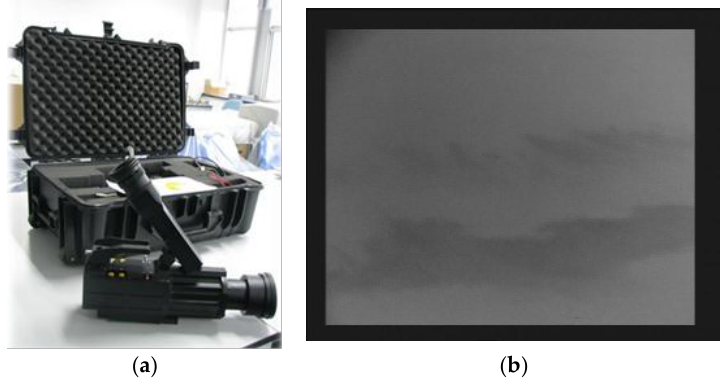
Figure 11. An oil spill image monitored by thermal infrared sensor: ( a ) thermal infrared sensor used in this study; and ( b ) an image captured by thermal infrared sensor.